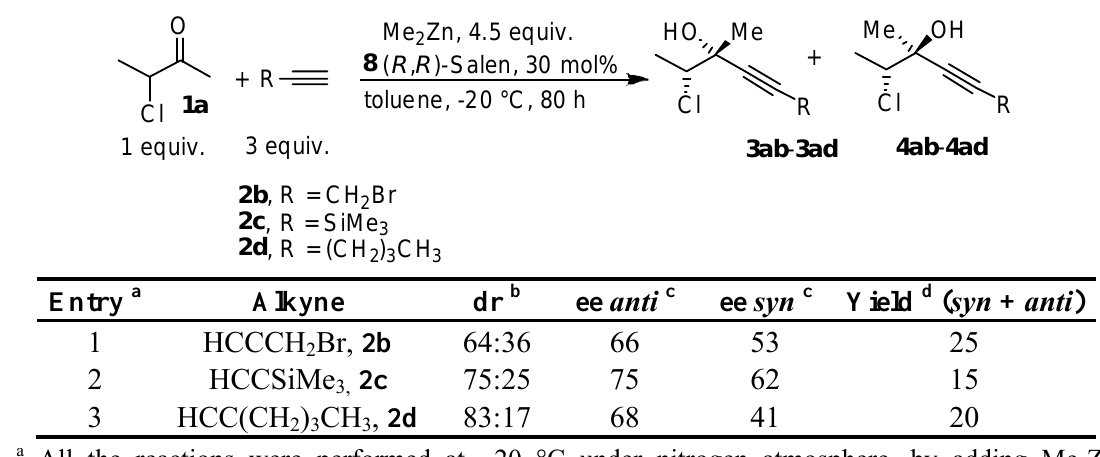
Table 4. Stereoselective addition of substituted acetylenes to 3-chlorobutanone promoted by ( R , R )-Salen